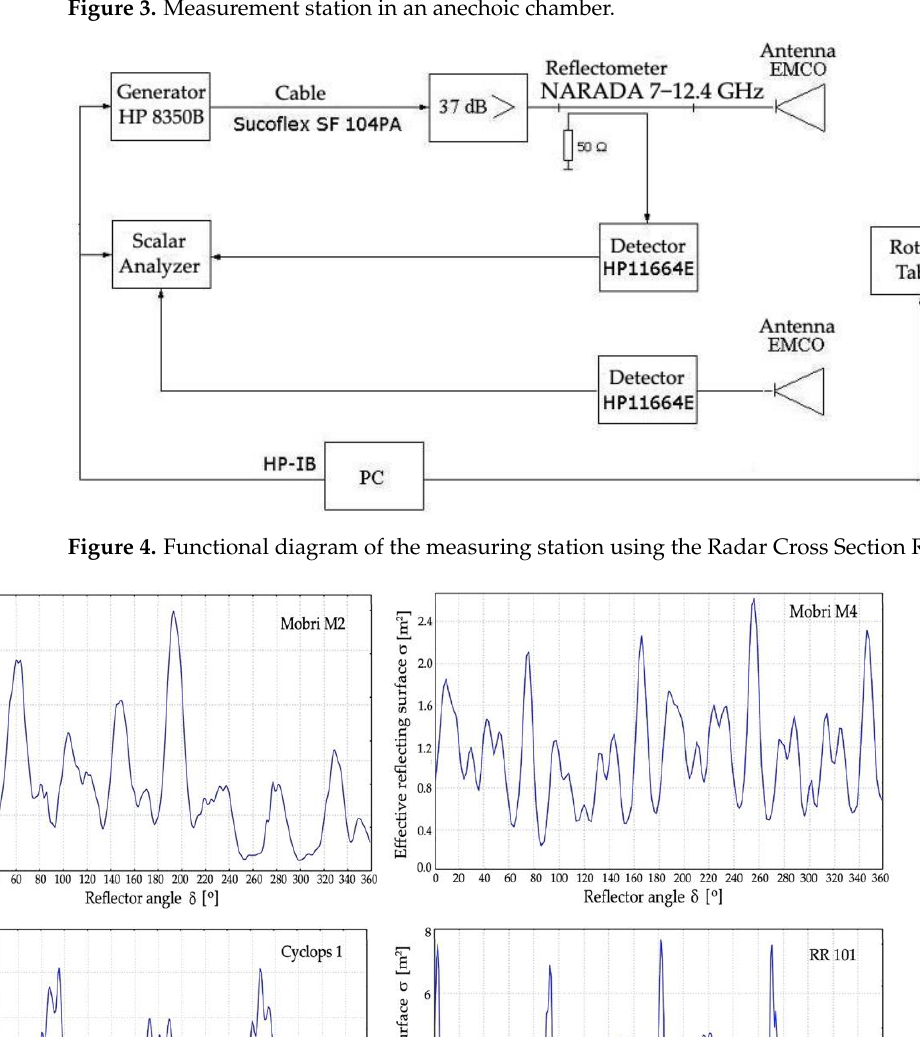
Figure 3. Measurement station in an anechoic chamber.